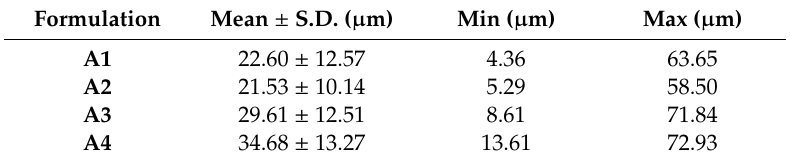
Figure 5. Micrographs of photoreactive suspensions at 10x magnification: ( a ) A1; ( b ) A2; ( c ) A3; ( d ) A4 formulation. Table5. Meandiameter ± S.D.,